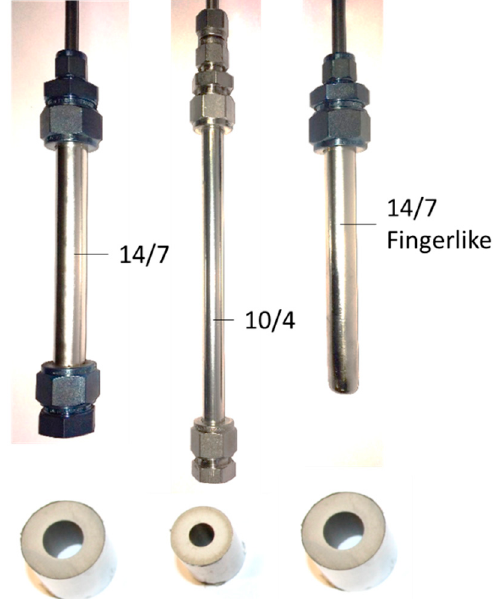
Figure 1. Sealed membranes with a cross-section; from left to right: A 14/7 mm outer/inner diameter (OD/ID) membrane, a 10/4 mm OD/ID membrane and a 14/7 mm OD/ID finger-like membrane.